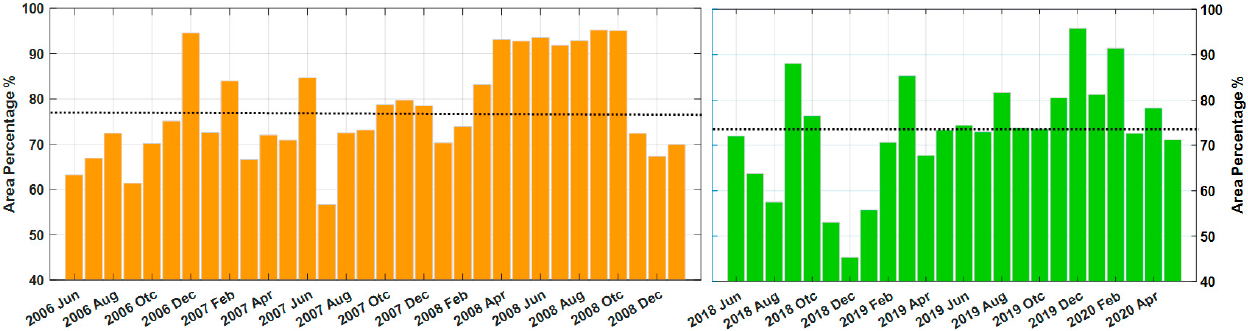
Figure 3. Percentages of drought-affected area for Drought 2006–2009 (Left—Orange) and Drought 2018–2020 (Right—Green).